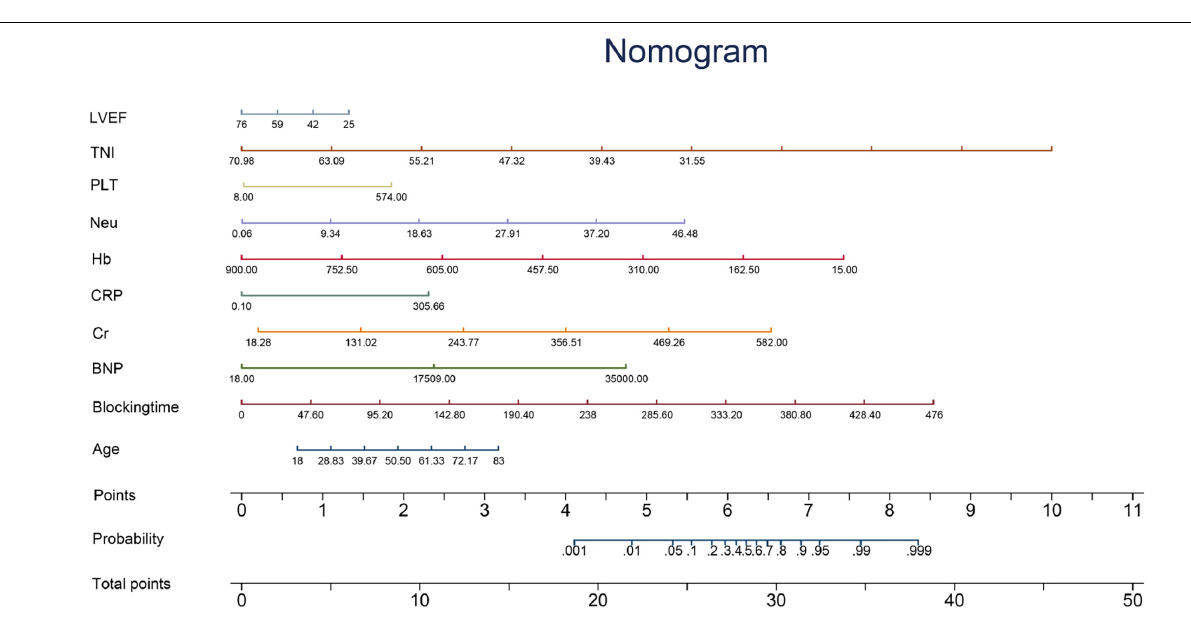
FIGURE 2 | Nomogram. The nomogram is constructed according to the regression coefficient in the model, which is convenient for better clinical application. Blocking time, blocking time of the ascending aorta during surgery; BNP, brain natriuretic peptide; Cr, serum creatinine; CRP, C-reactive protein; Hb, hemoglobin; Neu, neutrophil count; PLT, platelet count; TNI, cardiac troponin I; LVEF, left ventricular ejection